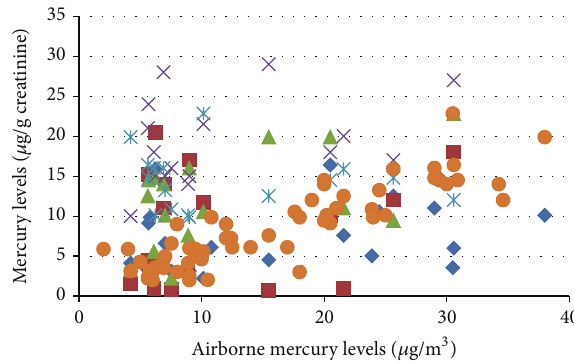
Figure 1: The correlation plot of airborne mercury levels versus dental health workers’ mercury